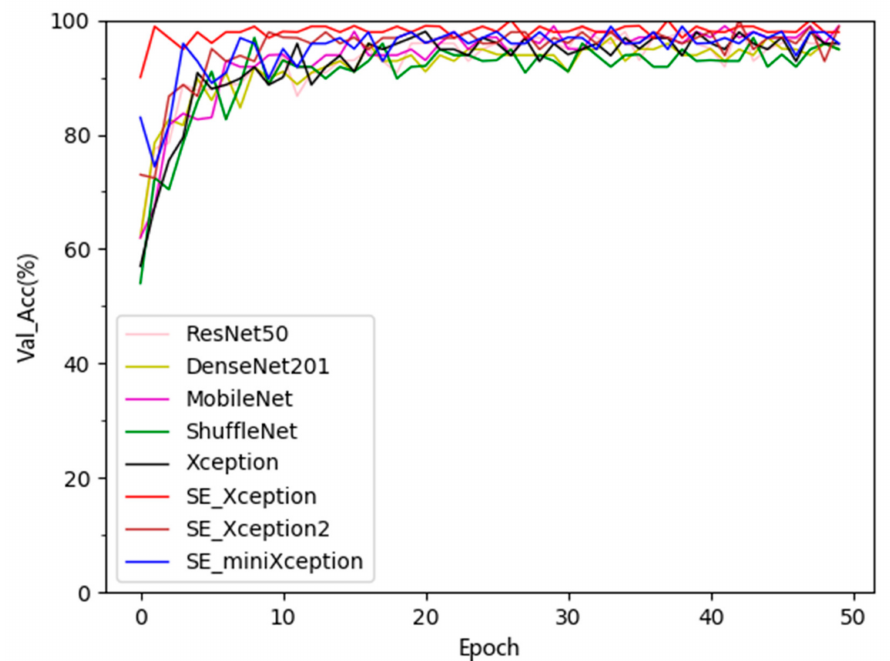
Figure 6. Comparison of convergence of SE_Xception and compared CNN models on the valida- tion set.